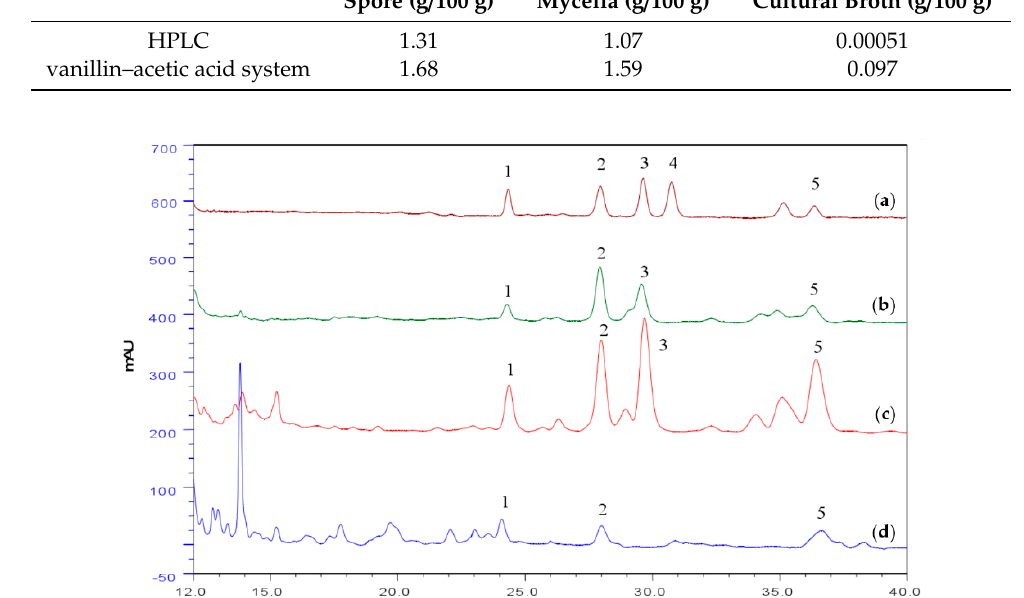
Table 1. Triterpenoids content of spore, mycelia and cultural broth of A. camphorata. Spore (g / 100 g)